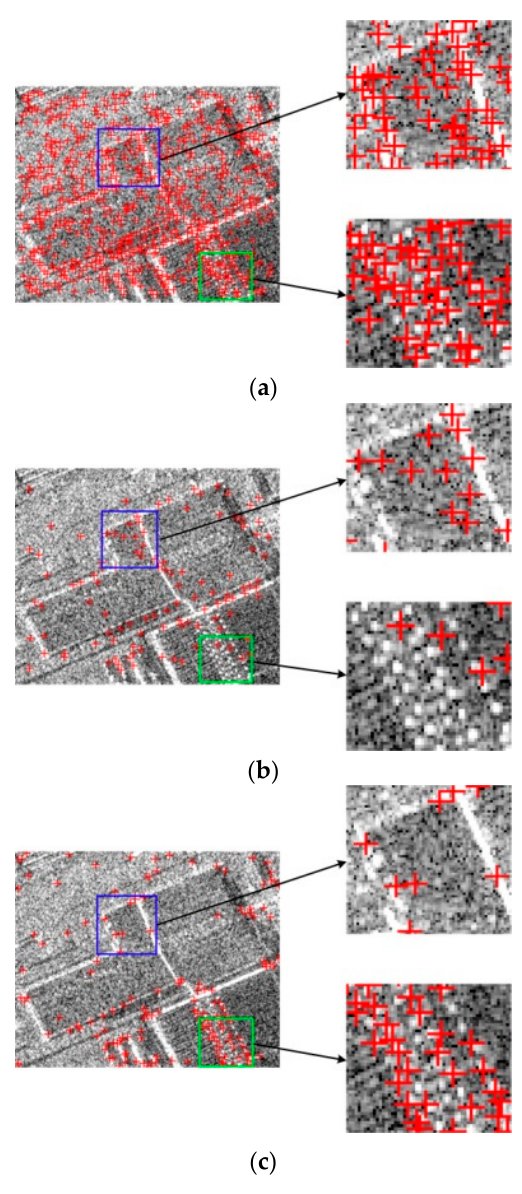
Figure 1. Interest point detection test. Point features are marked with red crosses. ( a ) Results of the original DoG detector in SIFT method [8]; ( b ) results of the improved DoG detector [14–16]; ( c ) results of the proposed method.